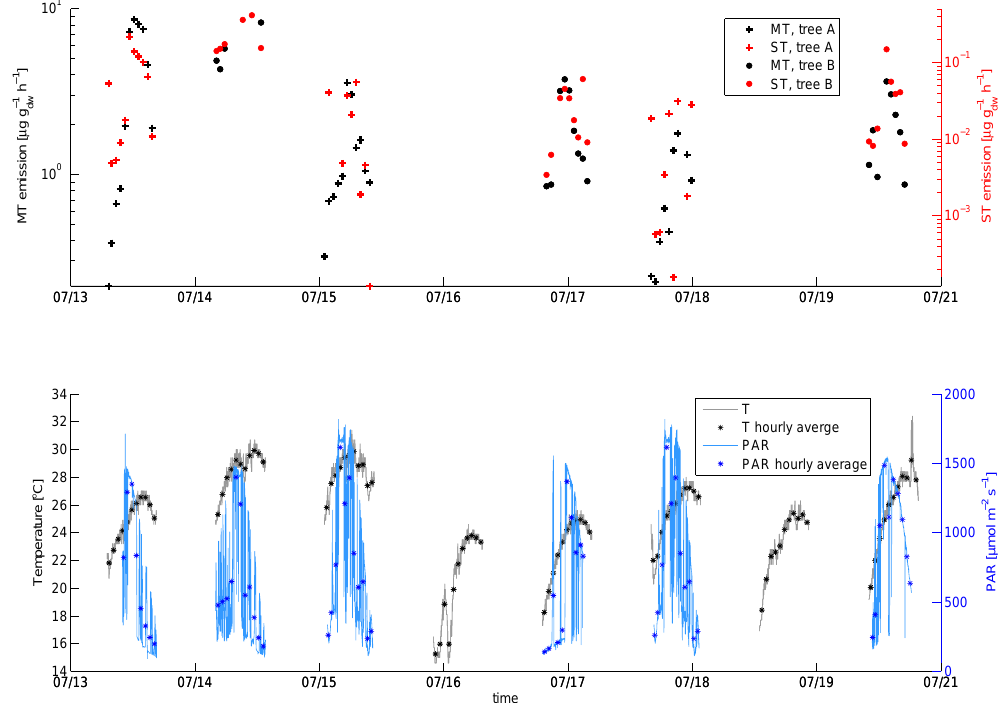
Fig. 5. An example of the measured mono- and sesquiterpene emission rates (top) and temperature and photosynthetically active radiation (PAR) (bottom) between 13 and 15 July